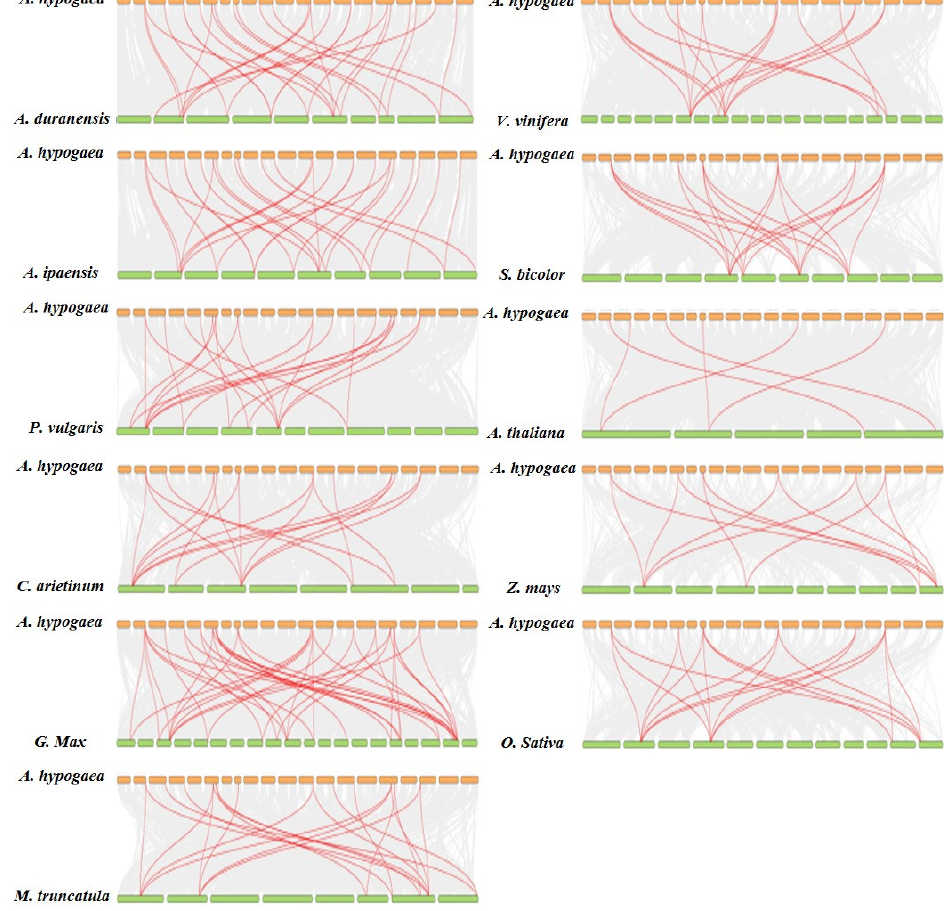
Figure 4. Syntenic analysis of PEBP genes between cultivated peanuts and other plants, including wild diploid peanuts, soybean, chickpea, alfalfa, common beans, Arabidopsis, grapes, rice, sorghum and maize. The gray lines at the bottom represent the collinear regions in rice and other genomes. The red lines represent the pairs of PEBP genes.